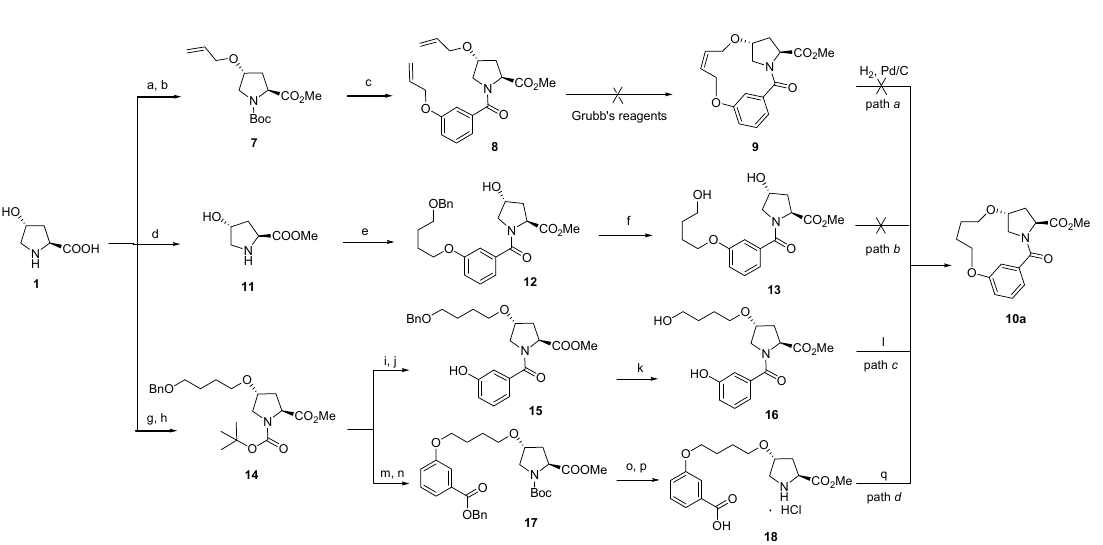
Table 2. Results of macrocyclization by Mitsunobu reactions and amide formation a .